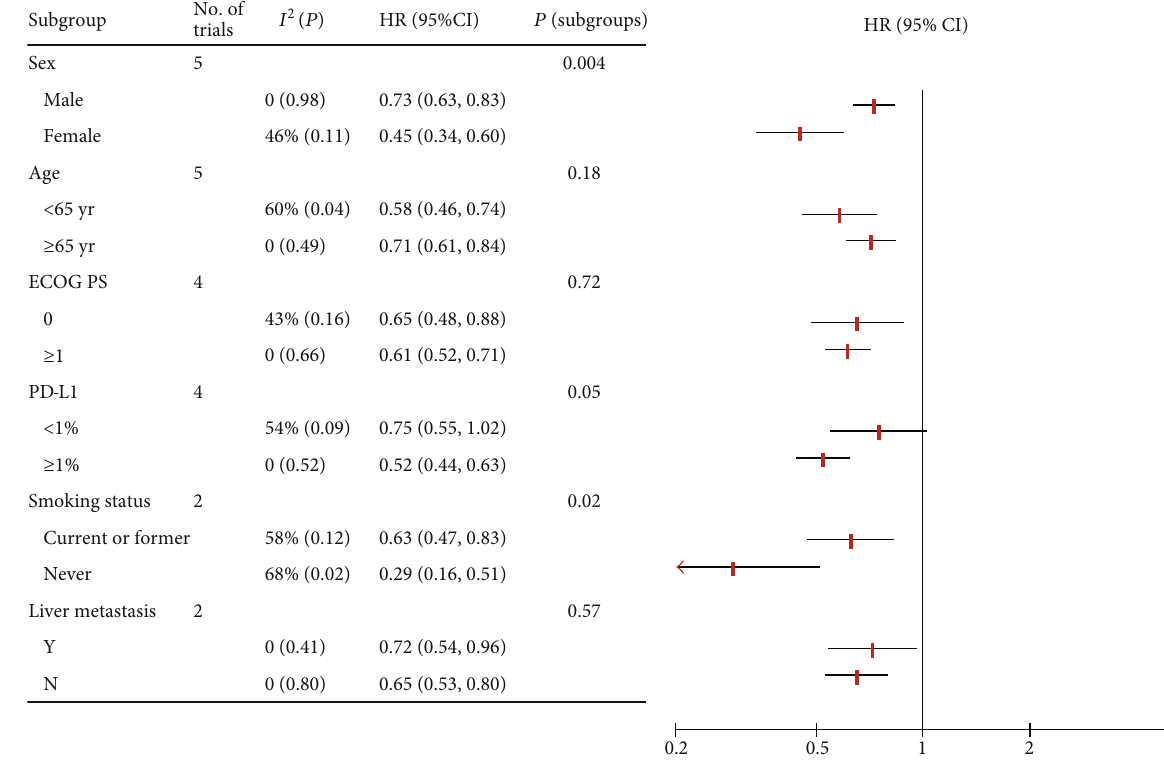
Figure 3: Subgroup analysis for combination therapy. HR: hazard ratio; Y: yes; N: